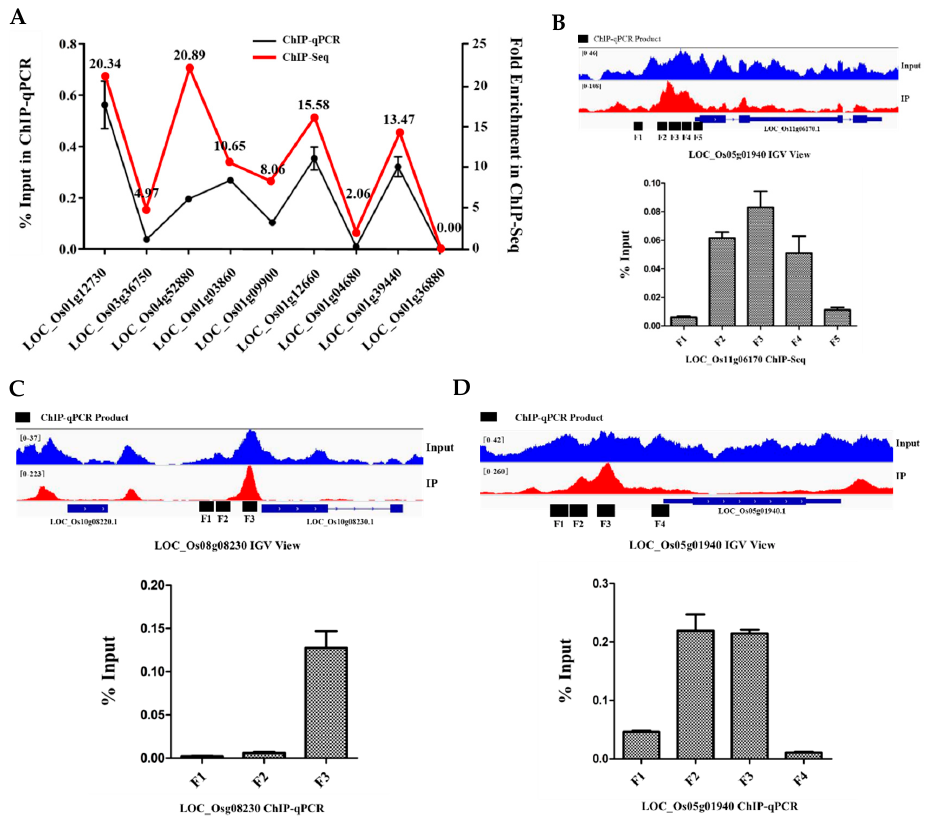
Figure 6. Verification of the ChIP-Seq results by ChIP-quantitative PCR (ChIP-qPCR). ( A ) Verification of the ChIP-Seq results by ChIP-qPCR including eight binding sites and one unbinding site (belonged to LOC_Os12g36880 ). ( B , D ) Verification of the ChIP-Seq results by ChIP-qPCR including 12 sites that belonged to three genes. The 12 sites at the promoter region of the three genes were arranged below the histogram. The primer pairs used in the RT-qPCR assay are represented with black lines in the promoter region (black boxes from left to right are F1 to F5 for LOC_Os11g06170 , F1 to F3 for LOC_Os10g08230 , and F1 to F4 for LOC_Os05g01940 ). The values in each column are the means of three independent replicates and error bars represent the SEM.